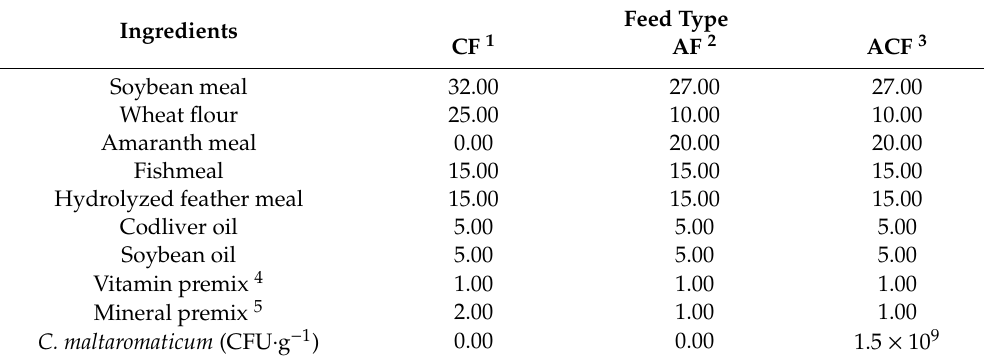
Table 1. Feeds composition (g · 100 g − 1 dry